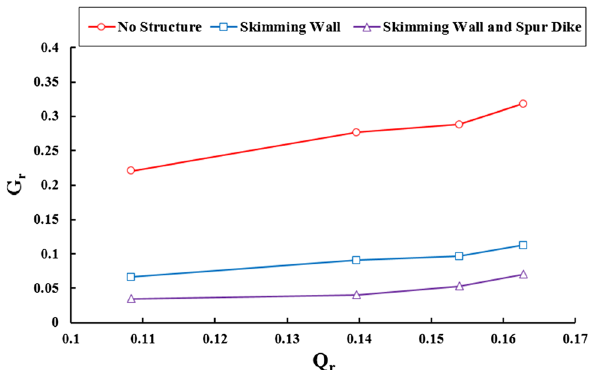
Fig. 11 The ratio of diverted sediment into the intake in terms of intake discharge